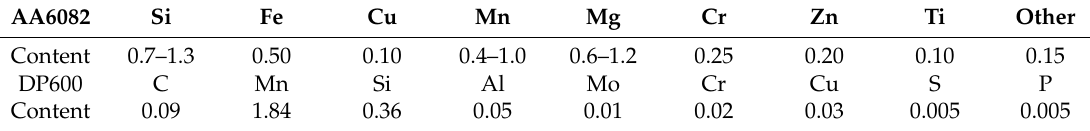
Table 1. Chemical compositions of AA6082-T6 aluminum alloy and DP600 galvanized steel